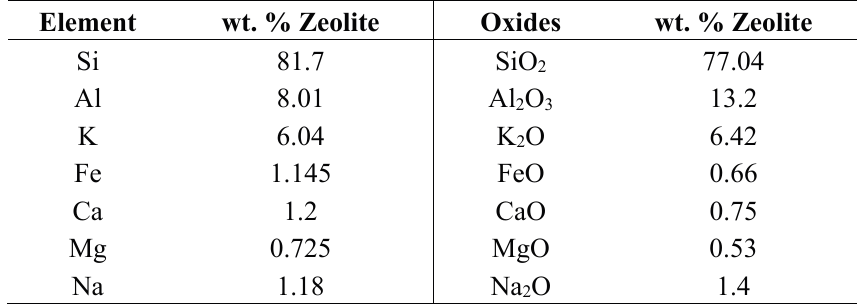
Figure 2. ( a ) SEM micrograph of the zeolite; ( b ) EDS mapping associated with the natural zeolite; and ( c – f ) maps of distribution of the elements Si, O, Al, K, Fe, and Ca, respectively. Table 1. Chemical composition of natural